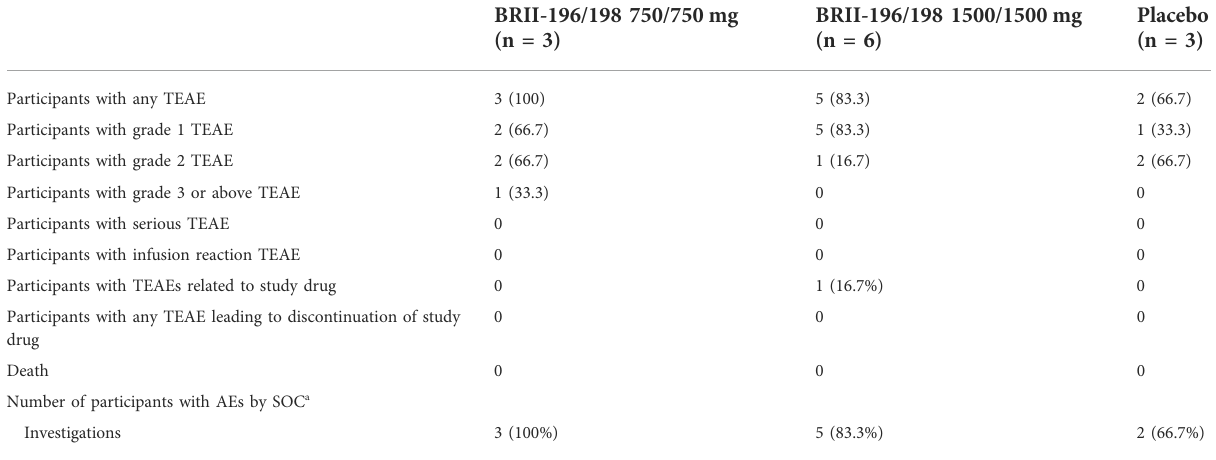
TABLE 4 Summary of adverse events of BRII-196-198-001